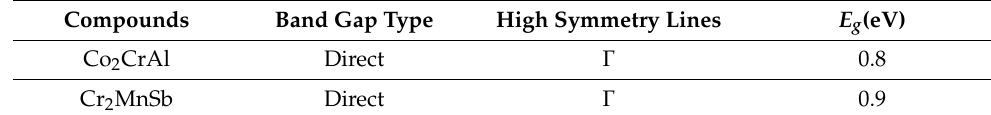
Table 7. The energy band gaps for the tetragonal I4/mmm (139) Heusler Co 2 CrAl and Cr 2 MnSb compounds in AFM state.